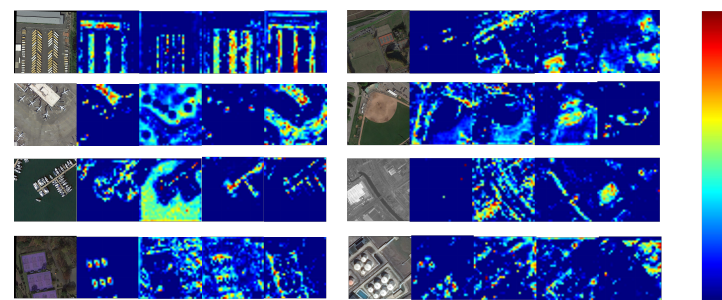
Figure 15. Visualization of the encoded scenario-object semantic information from the global attention network (GA-Net). The four feature maps from different channels behind each image visualize the response of different objects, and these feature maps collectively reflect the semantic relationship between the scene and the objects. The more biased to blue, the lower the response value. For that reason, the GA-Net branch obtains the distribution information of each part of the scene and encodes the information between the scene and the